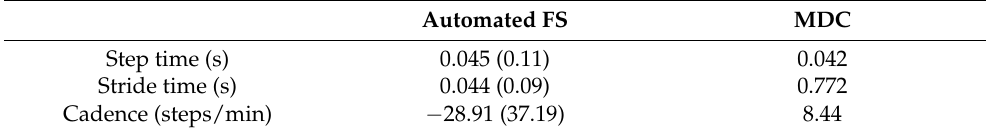
Table 4. Average and standard deviation (in brackets) difference between manual and automated foot strike stride parameter outcome measures for the 6M-FS model. MDC = minimum detectable change. Automated FS MDC Step time (s) 0.045 (0.11)